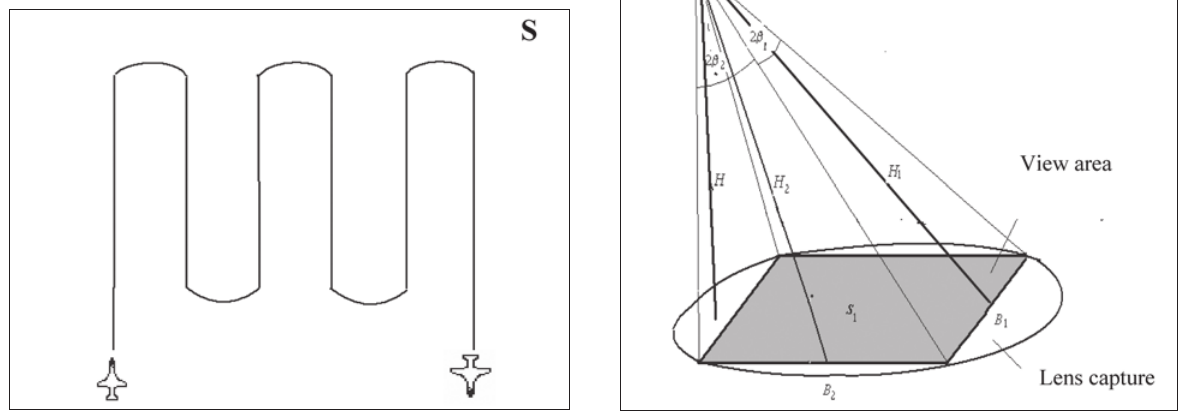
Fig. 3. Object identification